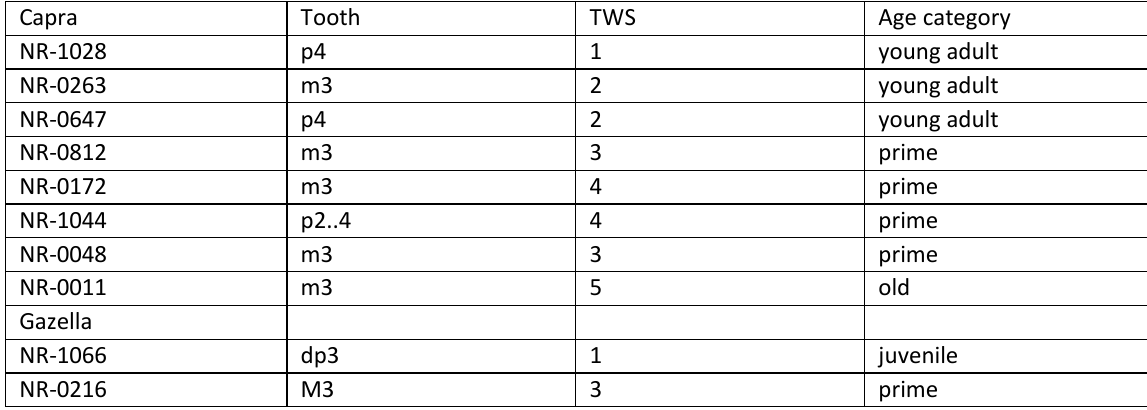
Table 6 : Tooth wear stages (Haber & Dayan, 2004) for caprines and